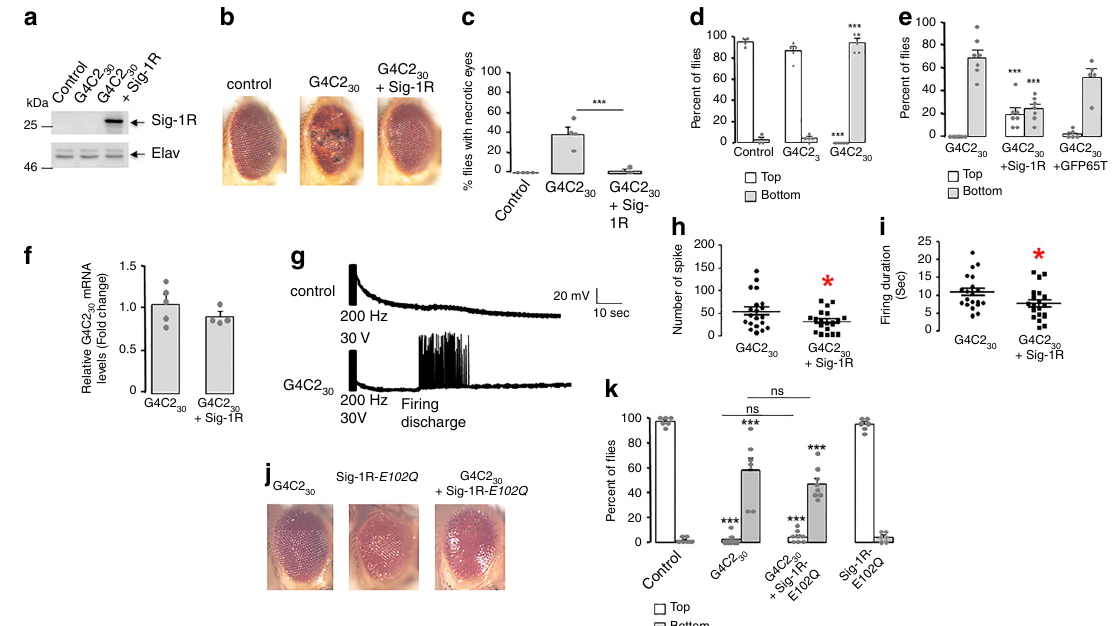
Fig. 8 Sig-1R, but not the Sig-1R- E 102 Q mutant, rescues the phenotype of fl ies expressing expanded (G4C2) repeats. a Western blot of human Sig-1R (Sigma-1 receptor) in Drosophila ; n = 3 independent experiments with similar results from biologically independent preparations. b Representative external eye morphology of fl ies (20 days after eclosion) expressing no transgene (control), 30 G4C2 repeats ((G4C2) 30 ) alone or together with human Sig-1R. c Quanti fi cation of fl ies presenting necrotic spots in the eyes; n = 4 independent sets of studies from a total of 91 fl ies in control, 48 in (G4C2) 30 , and 68 in (G4C2) 30 + Sig-1R group; statistics at the end. d Climbing performances (observation starts at 1 min) of 4-day-old fl ies expressing no transgene (control), 3 ((G4C2) 3 ) or 30 G4C2 repeats ((G4C2) 30 ). n = 8 fl ies/group; number of trials: control, 4; (G4C2) 3 , 5; (G4C2) 30 , 5. *** p < 0.001 versus control; statistics at the end. e Climbing performances of 4-day-old fl ies expressing (G4C2) 30 alone or with Sig-1R or the green fl uorescent protein GFP (GFP65T) in neurons. n = 8 fl ies/group; number of trials: (G4C2) 30 , 7; (G4C2) 30 + Sig-1R, 7; (G4C2) 30 + GFP65T, 5; statistics at the end. f Sig-1R does not modify G4C2 30 mRNA expression. mRNA levels of G4C2 30 ( n = 5) or (G4C2) 30 + Sig-1R ( n = 4) were normalized to actin. Data are means ± S.E.M.; unpaired two-tailed t -test ( p = 0.2950). g Representative traces of evoked responses after an electroconvulsive stimulation (30 V, 200 Hz) in fl ies expressing no transgene (control) or (G4C2) 30 . h Number of spikes in fi ring discharges induced by an electroconvulsive stimulation on fl ies ( n = 20/group) expressing (G4C2) 30 alone or together with Sig-1R. Data are means ± S.E.M; unpaired two-tailed t -test (* p = 0.0385). i Duration of fi ring discharges for fl ies ( n = 20/ group) expressing (G4C2) 30 alone or together with Sig-1R. Data are means ± S.E.M.; unpaired two-tailed t -test (* p = 0.0375). j Expression of Sig-1R-E102Q in retina leads to rough eye phenotype. k Sig-1R- E 102 Q failed to ameliorate climbing performances of fl ies (4 days old) expressing expanded G4C2 repeats. Control: no transgene. n = 8 fl ies per group; number of trials: Control, 6; (G4C2) 30 , 7; (G4C2) 30 + Sig-1R- E 102 Q , 8; Sig-1R- E 102 Q , 6. Statistics for c , d , e , k